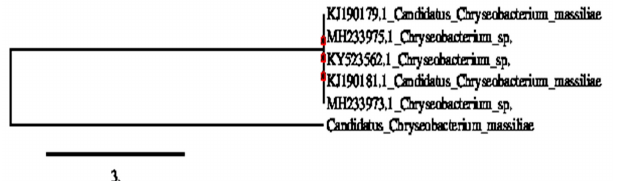
Fig. 4. Phylogenetic tree, based on neighbor-joining, derived from an alignment comprising C 5' end partial region sequences suggesting NP9 isolate as Candidatus chryseobacterium massiliae